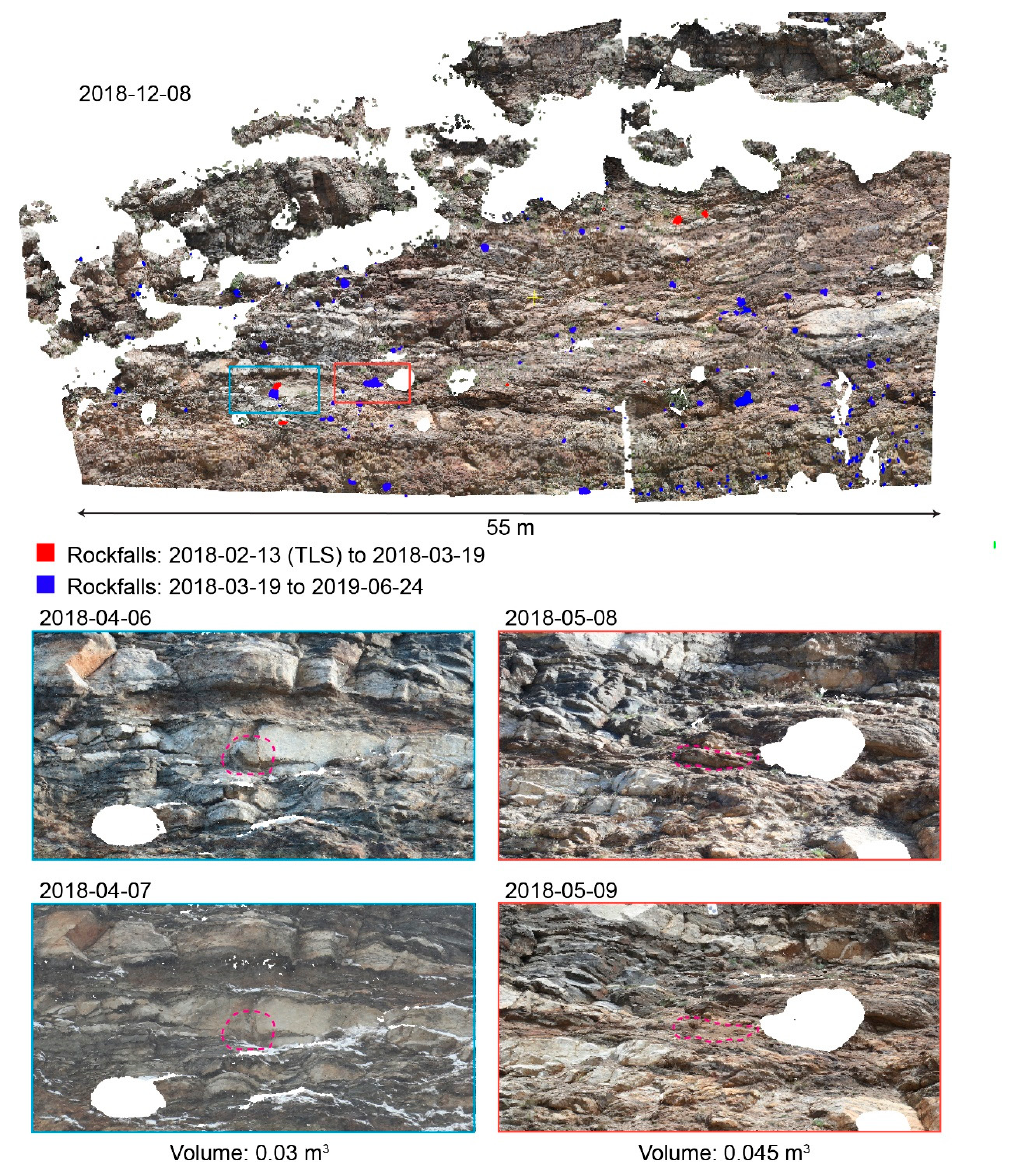
Figure 11. Cumulative rockfalls detected since start of time lapse monitoring.